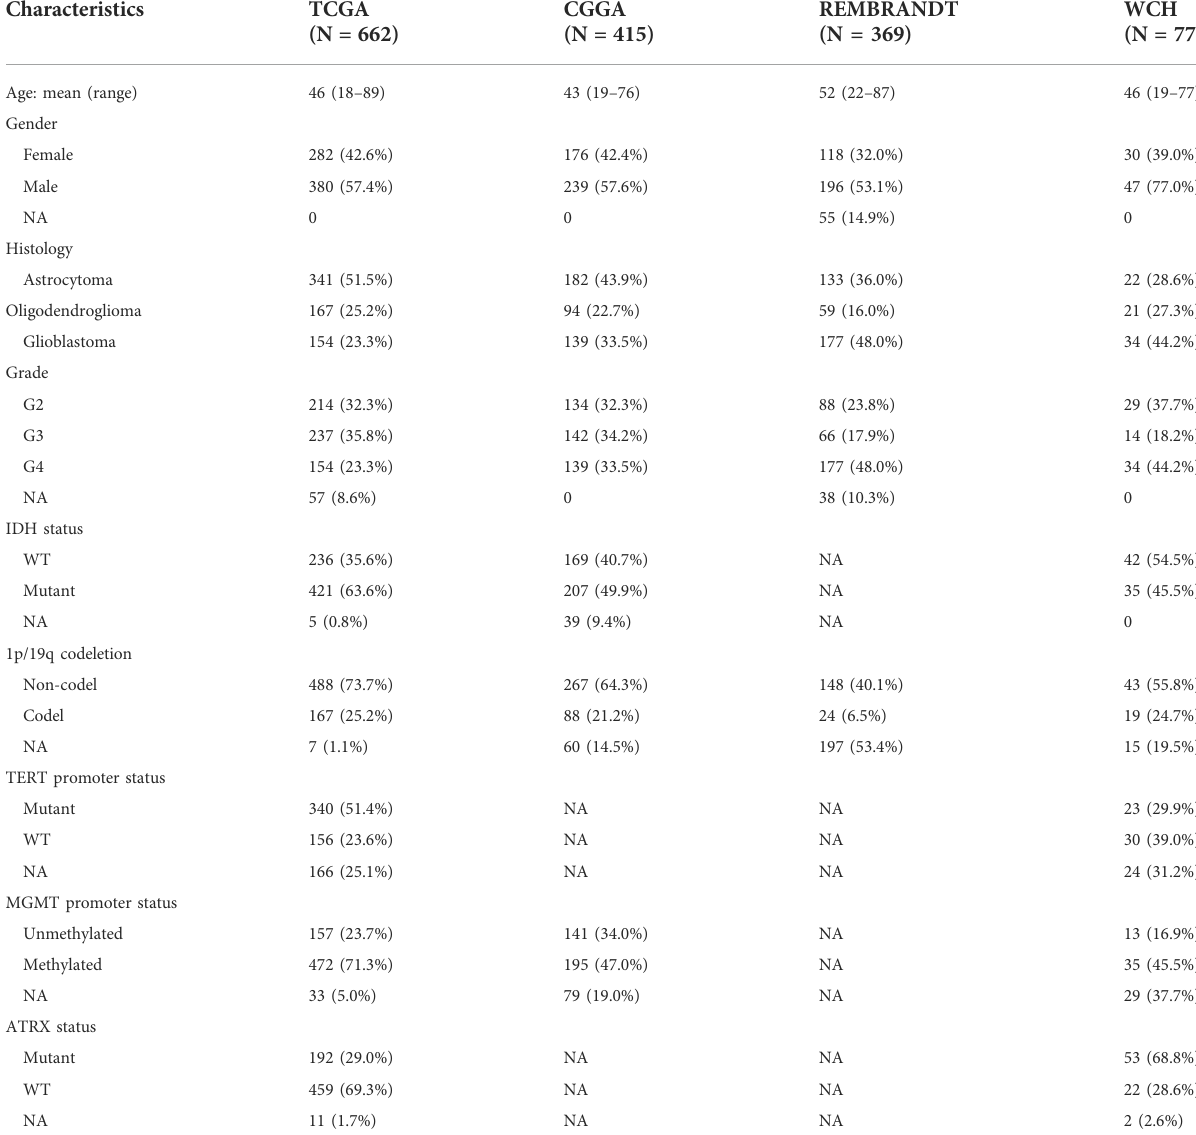
TABLE 1 Clinicopathological characteristics of patients in TCGA, CGGA, REMBRANDT, and WCH cohort.